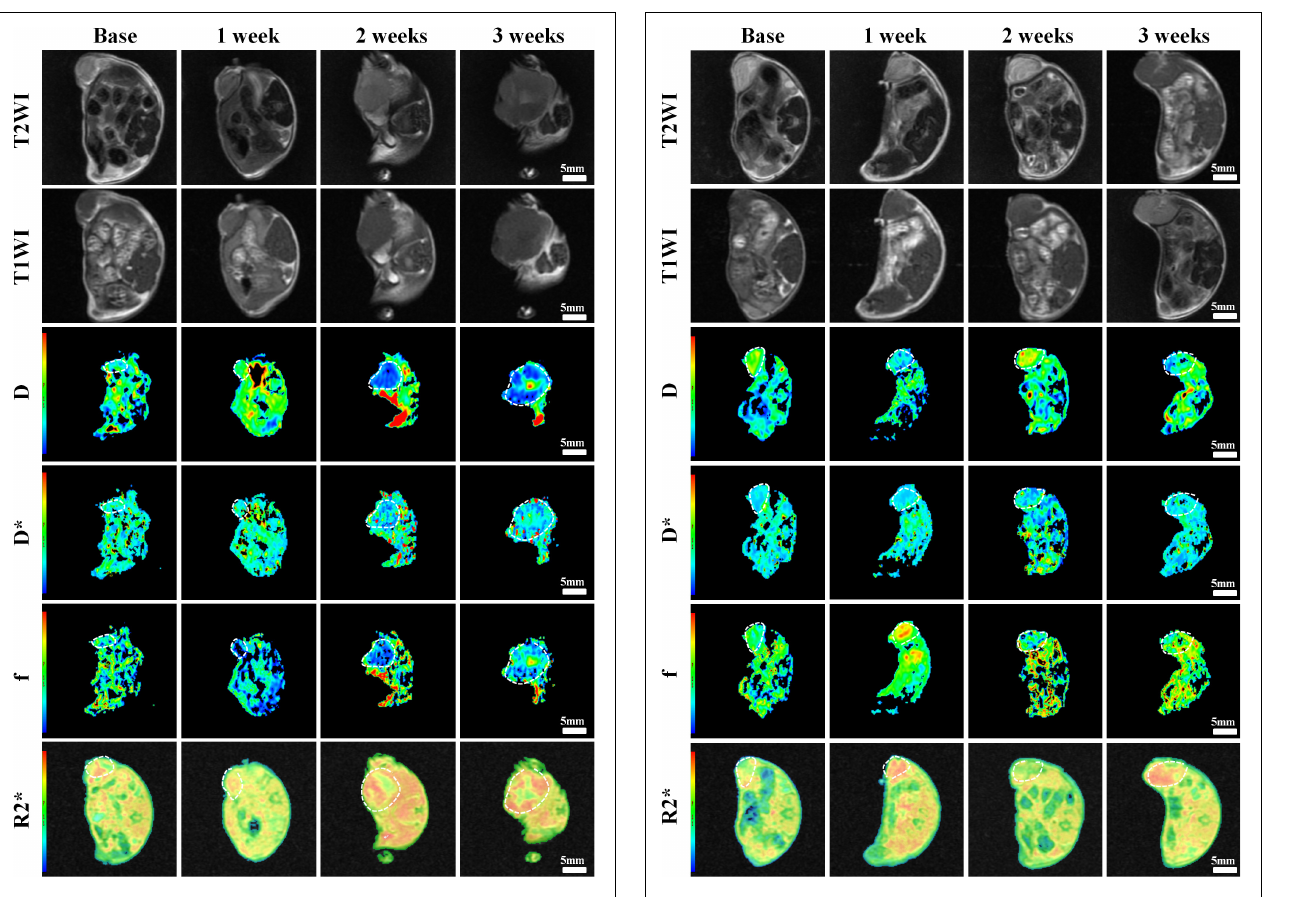
FIGURE 5 | Axial T1WI, T2WI, and pseudocolur maps of D, D*, f, and R2 values at different time points treated with 2 mg/kg of cRGD-PLGA@DOX (Group C). D value is the pure diffusion of water molecule. D* value refers to perfusion-related diffusion. F value is the perfusion fraction. R2* value reflects the tumor hypoxia. The white circles plot the tumor area.